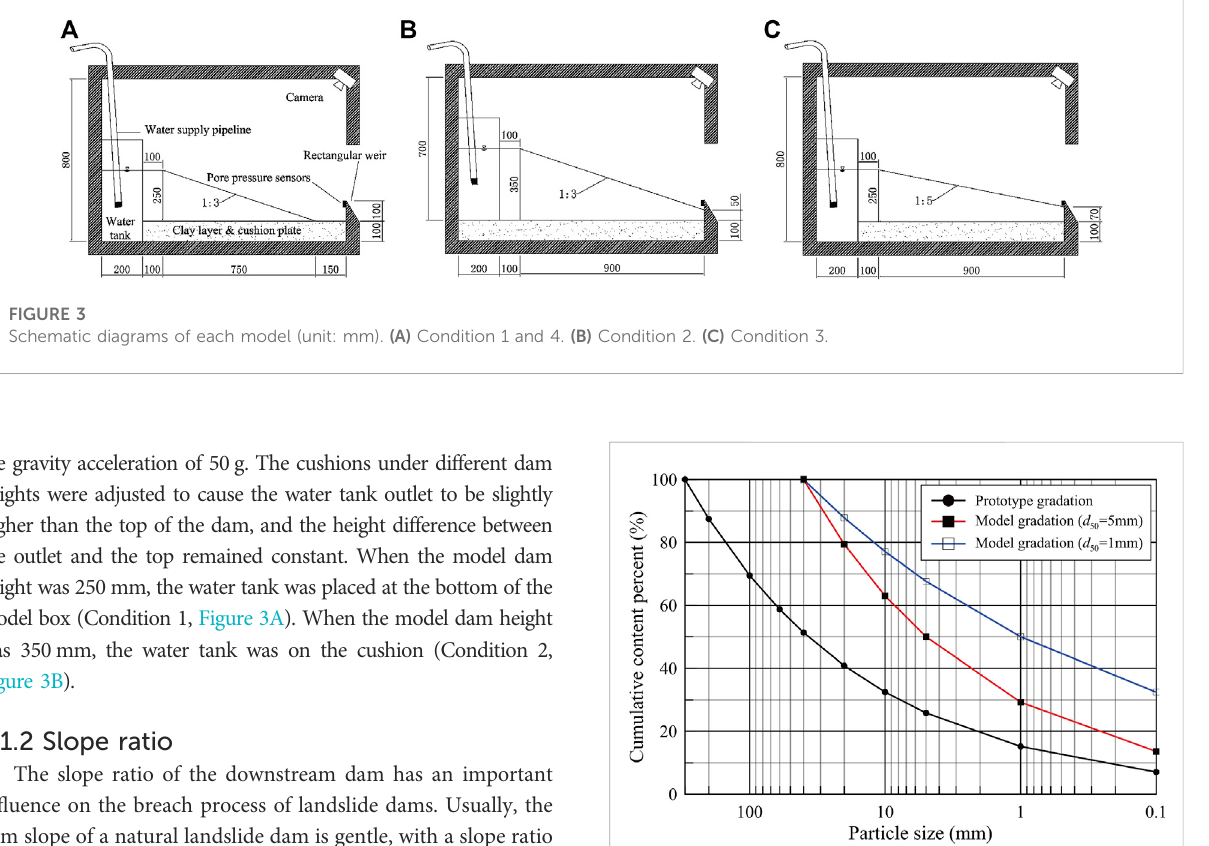
FIGURE 4 Gradation curves of prototype and model.